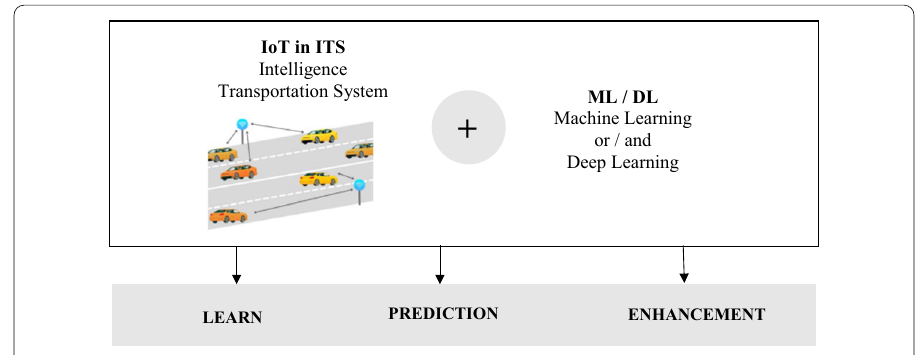
Fig. 1 IoT in ITS with machine and deep